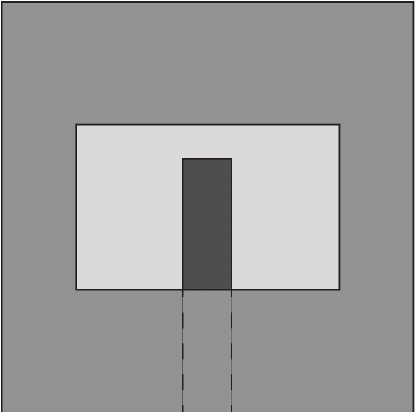
Figure 24. Geometry of a planar slot antenna (redrawn from [93]). Dark gray top metal face, medium gray bottom metal face, and light gray dielectric